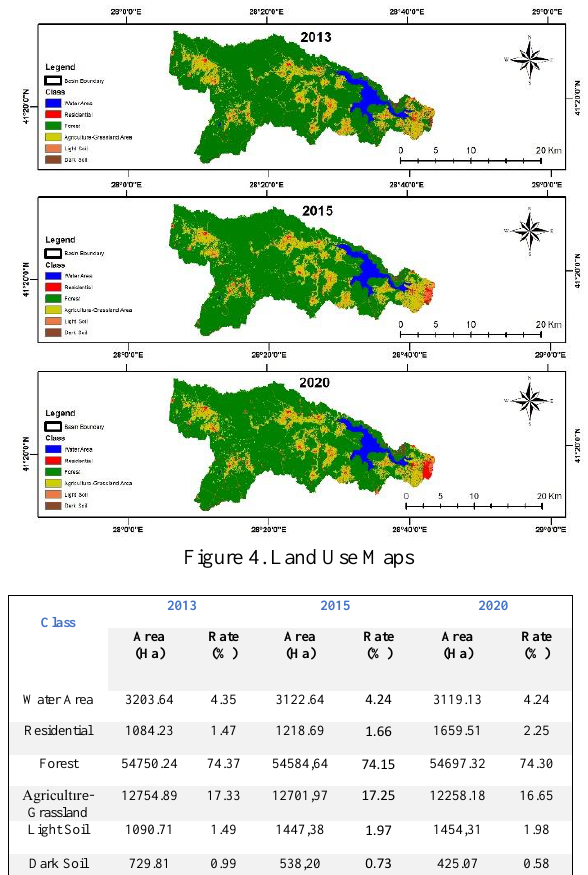
Table 1. Land Use Distribution